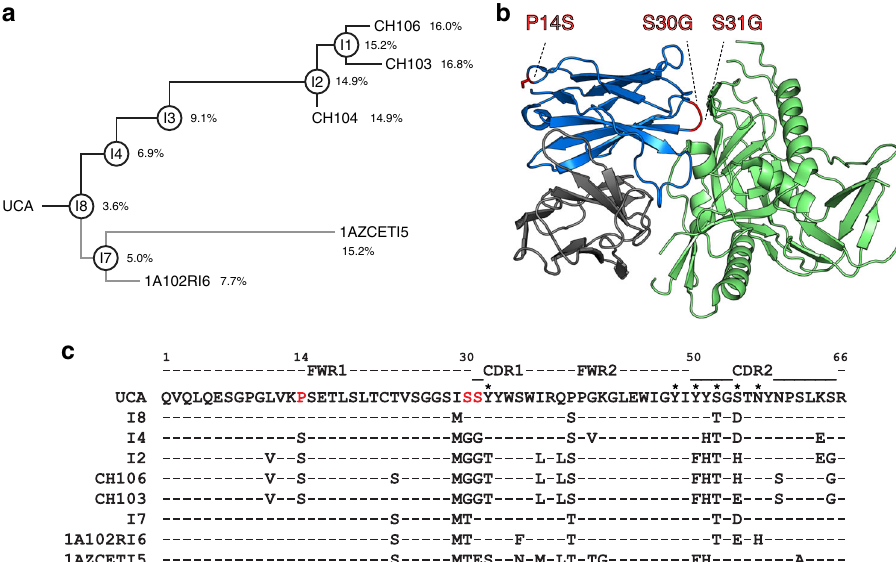
Fig. 2 Heavy chain FWR1 mutations in the CH103 bnAb lineage. a The mature CH103 bnAbs were isolated from an HIV-1 infected African patient 24 . The unmutated common ancestor (UCA) and intermediate antibodies (Is) were inferred and each mAb was produced as described previously 24 . The % V H mutations are indicated on the phylogram. b The location of the mutations (red) P14S (FWR1), S30G and S31G (HCDR1 proximal) that are selected in I4 are shown for the CH103 bnAb heavy chain (blue) in complex with gp120 (green). The CH103 light chain is shown in gray. The CH103-gp120 bound structure was originally solved in complex with only the outer domain of gp120 24 . For visualizing the location of the CH103 mutations in the context of a more fully resolved gp120, the CH103 complex structure was superimposed onto a gp120 core that included the inner domain (PDB: 4RQS). A portion of the V1V2 loop in the gp120 has been removed for clarity. c V H sequence (partial) alignment of UCA, intermediates (I8, I4, I2, I7), mature CH103 bnAbs (CH106, CH103), and lower branch mAbs (1A102RI6, 1AZCETI5) depict the mutations acquired during af fi nity maturation. Mutations of 14 P to S and 30 SS to GG (shown in red) in the FWR1 and HCDR1 proximal regions, respectively, were fi rst observed in the intermediate I4 and maintained in each of the later evolving intermediates leading up to the mature bnAb CH103. Interestingly, these mutations were not observed in the lower branch antibodies (I7, 1A102RI6, 1AZCETI5) and binding to heterologous Env (B.63521) was orders of magnitude weaker compared to the mAbs of the CH103 bnAb branch (Supplementary Table 5). Asterisks mark residues that make direct contact with antigen